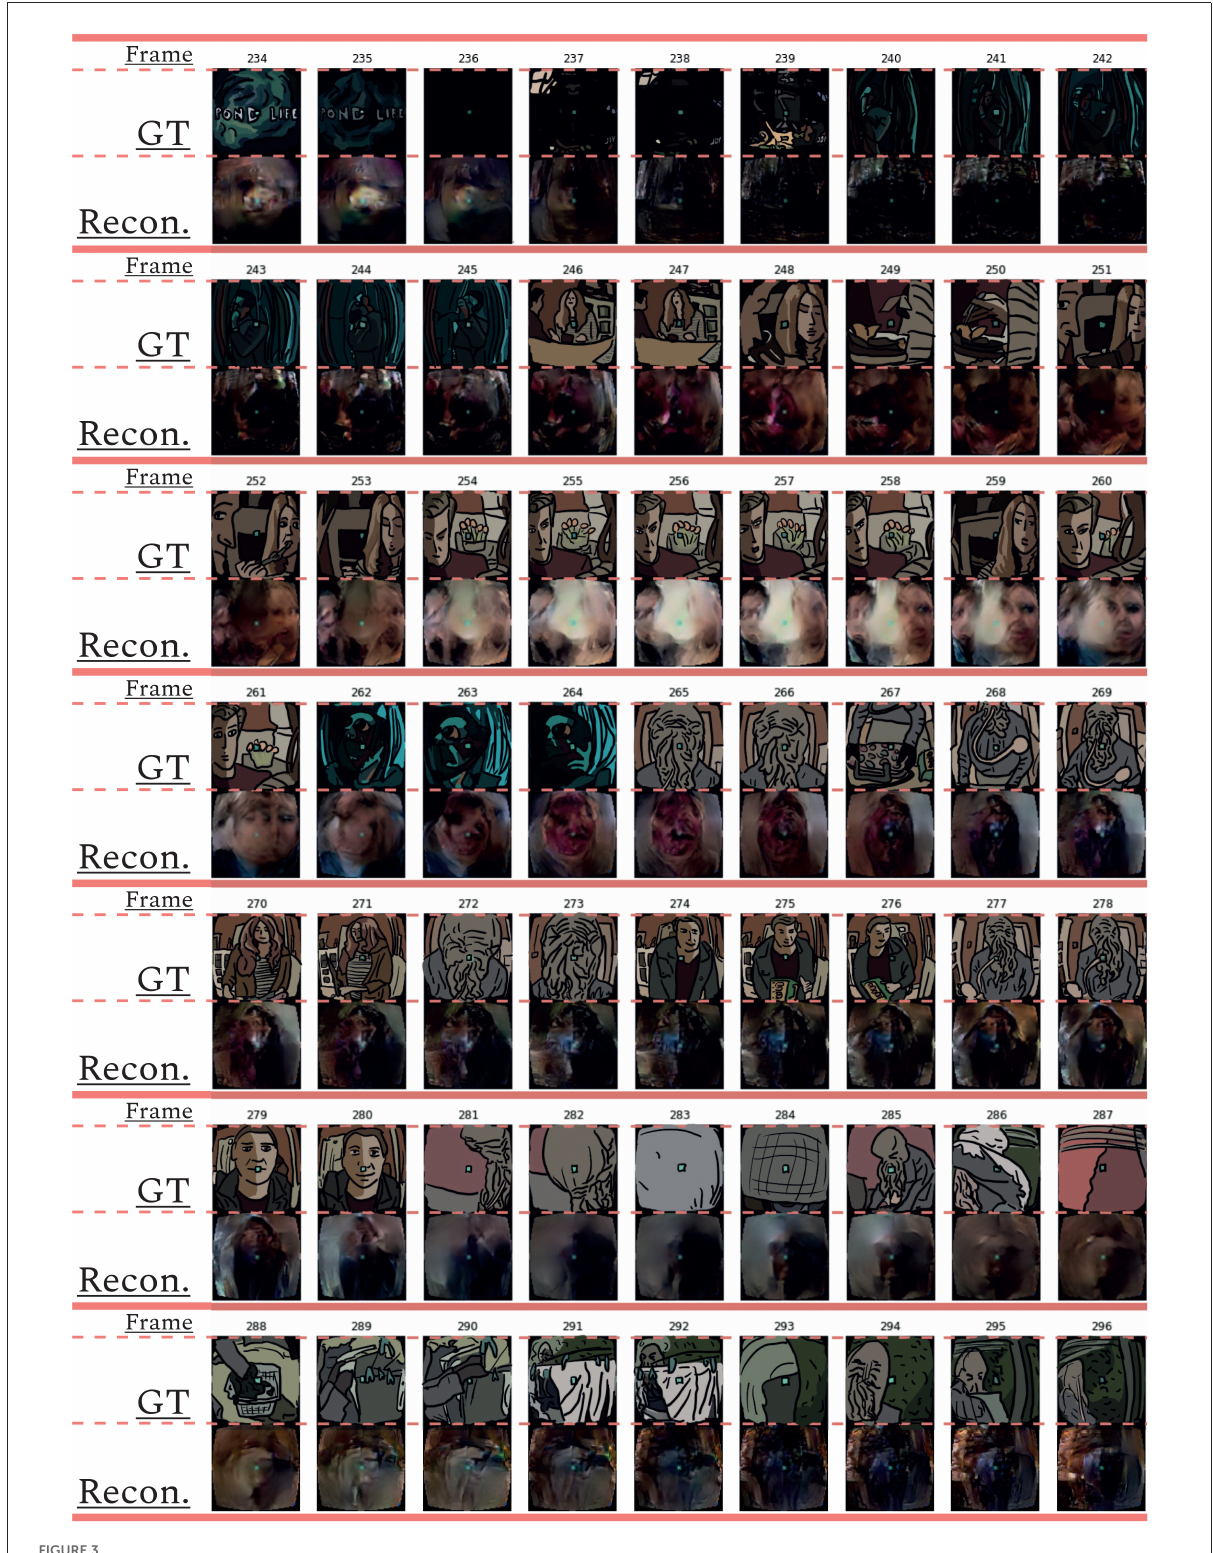
FIGURE3 Sequential of reconstructed frames. Consecutive frame sequence from a video fragment of the test data [ground truth (GT)] and the corresponding reconstructions